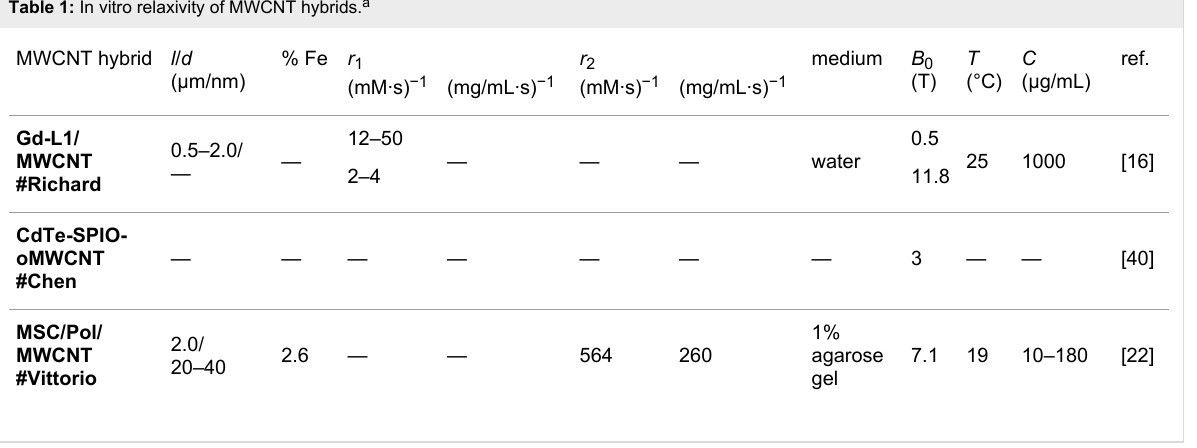
Table 1: In vitro relaxivity of MWCNT hybrids. a